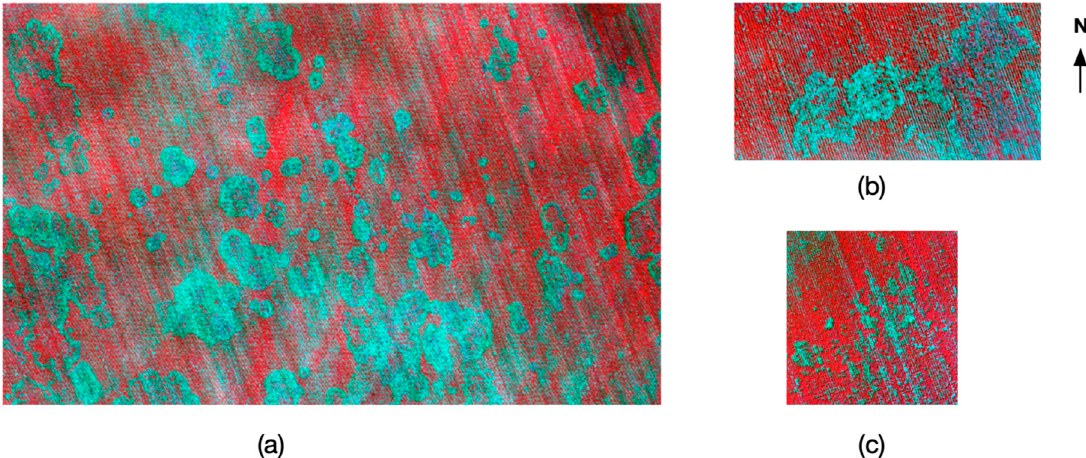
Figure 5. Multispectral color infrared (CIR) images for ( a ) Chase field (Scale 1:3000), ( b ) School house field (Scale 1:1550), and ( c ) West Poncho field (Scale 1:2110).